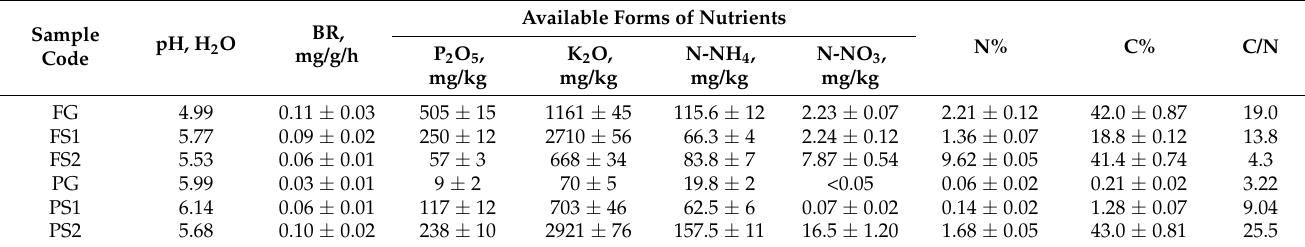
Table 1. Routine soil analysis results (average value ± standard